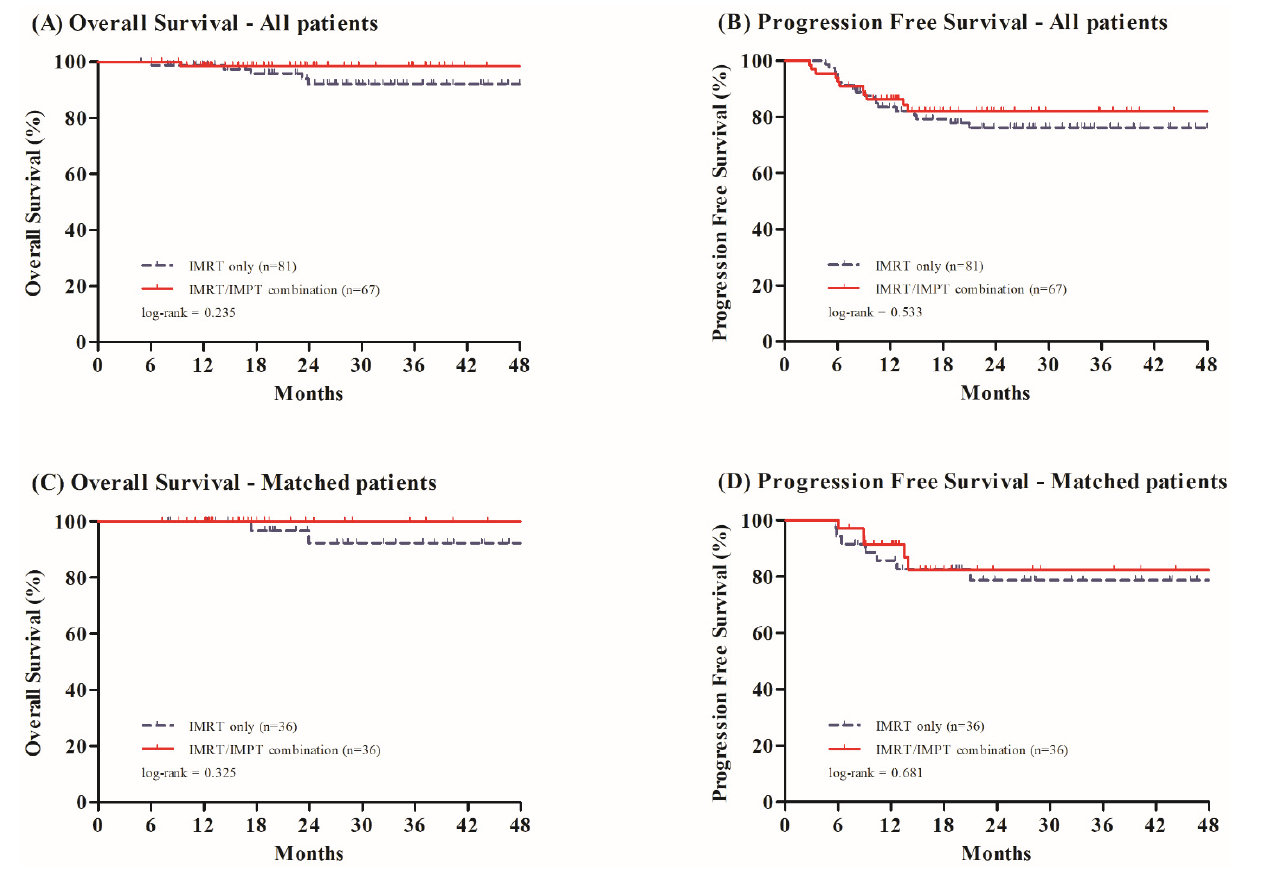
Figure 1. Overall survival and progression free survival among all patients ( A , B ) and matched patients ( C , D ) according to treatment group. IMRT, Intensity-Modulated Radiation Therapy; IMPT, Intensity-Modulated Proton Therapy.